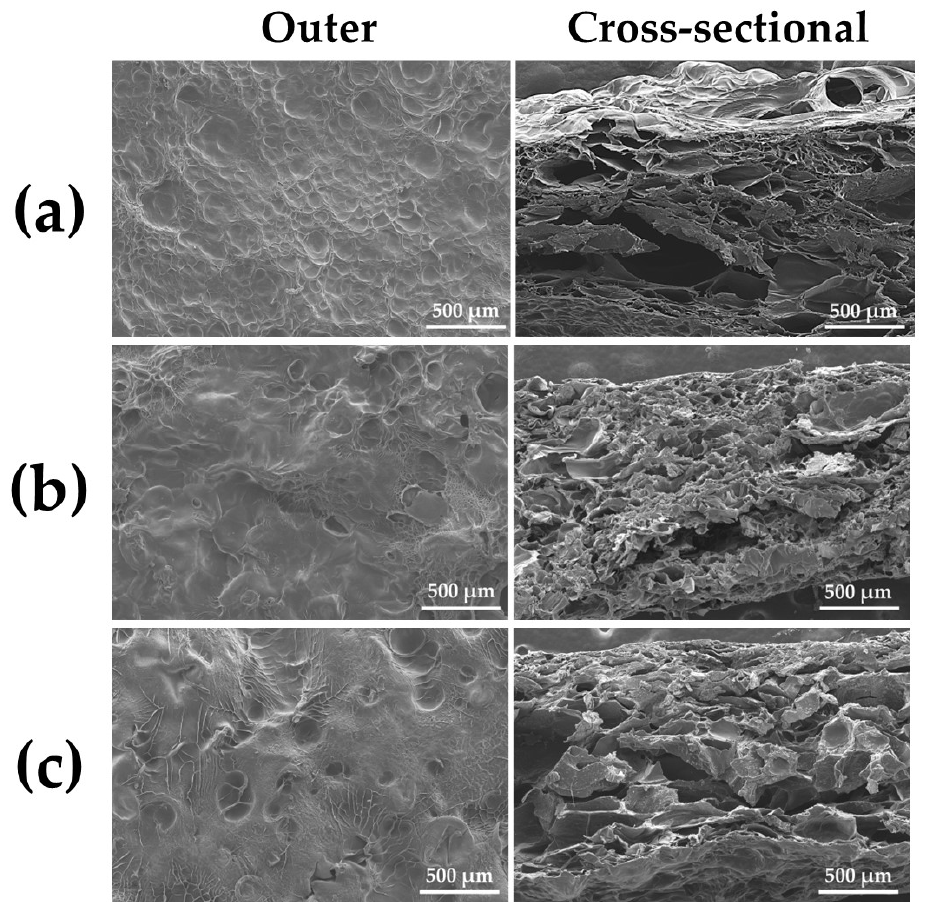
Figure 7. SEM photomicrograph of the outermost (50× magnification) ( left ) and cross-sectional (50× magnification) ( right ) surfaces of ( a ) dry gelatin-infiltrated control Col powder (Col control + AG) and two alternate immersed composite granules: ( b ) (AI 20 min 5Cy Col/Hap + AG) and ( c ) (AI 60 min 5Cy Col/Hap + AG).